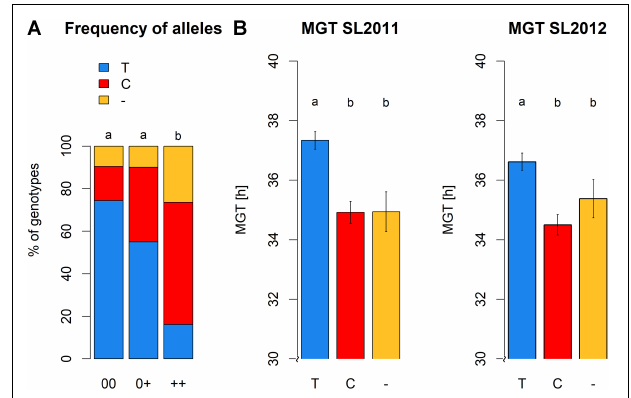
FIGURE 8 | (A) Allele frequencies of peak marker Bn-A01-p26914512 within the different seed quality groups. 00, low erucic acid, low glucosinolate content; 0+, low erucic acid, high glucosinolate content; ++, high erucic acid, high glucosinoate content. (B) Mean germination time of genotypes grouped with regard to their marker allele predominant at locus Bn-A01-p26914512, calculated for seed lot 2011 and seed lot